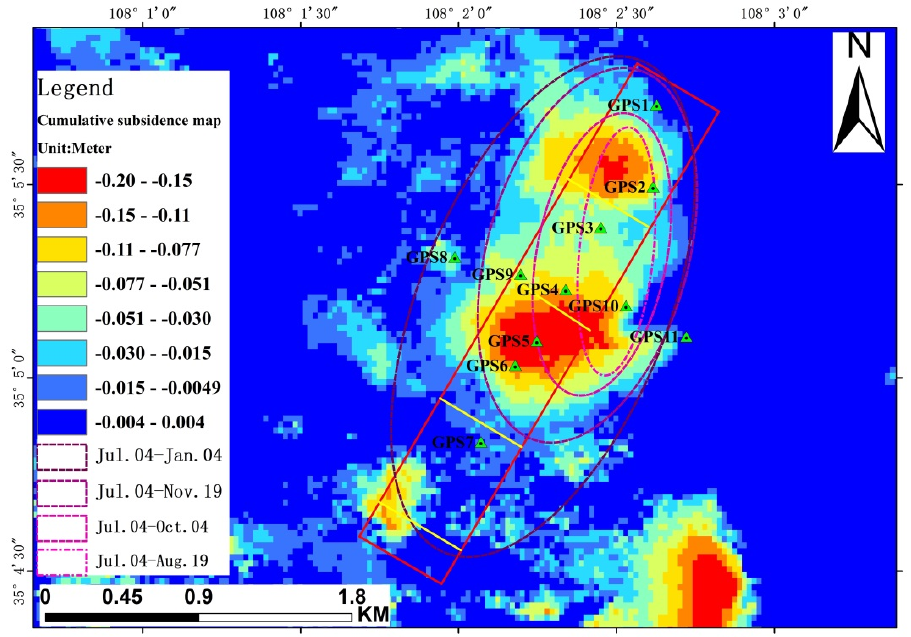
Figure 4. Cumulative subsidence map.